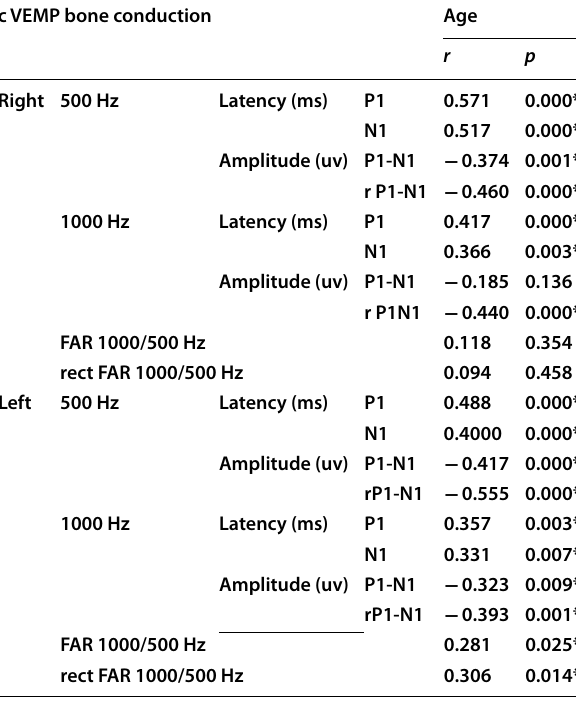
Table 5 Correlation coefficient ( r ) between age and air conduction cVEMP parameters at 500 and 1000 Hz in the right and left ears of the study participants